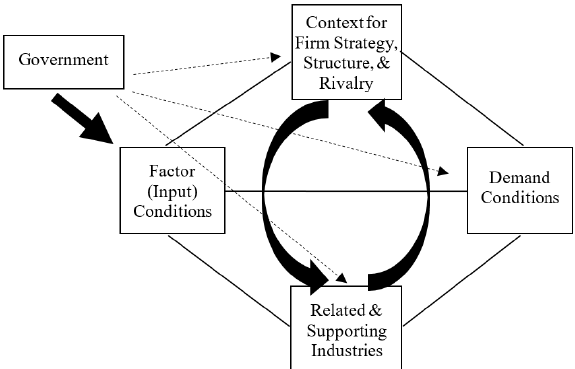
Figure A.1: Porter diamond model adapted for TW industry clustering